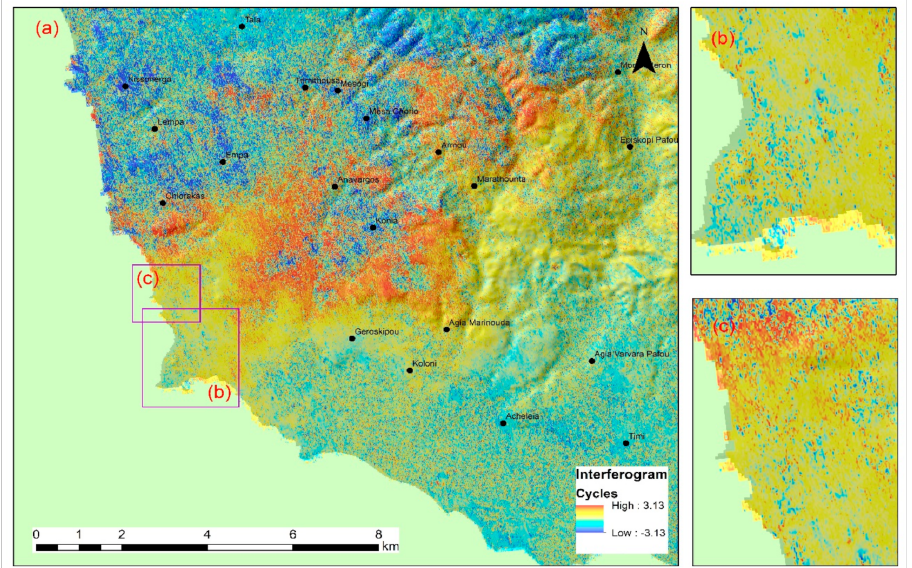
Figure 3. Di ff erential interferogram after the application of phase filtering at ( a ) western Cyprus; ( b ) “Nea Paphos”; and ( c ) “Tombs of the